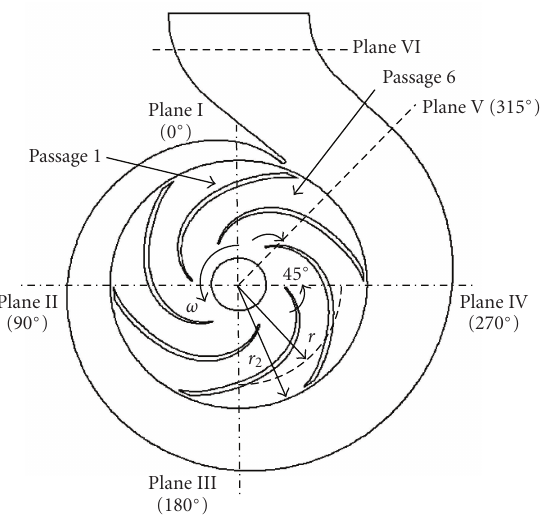
Figure 2: Cross-sectional plane location at volute casing.